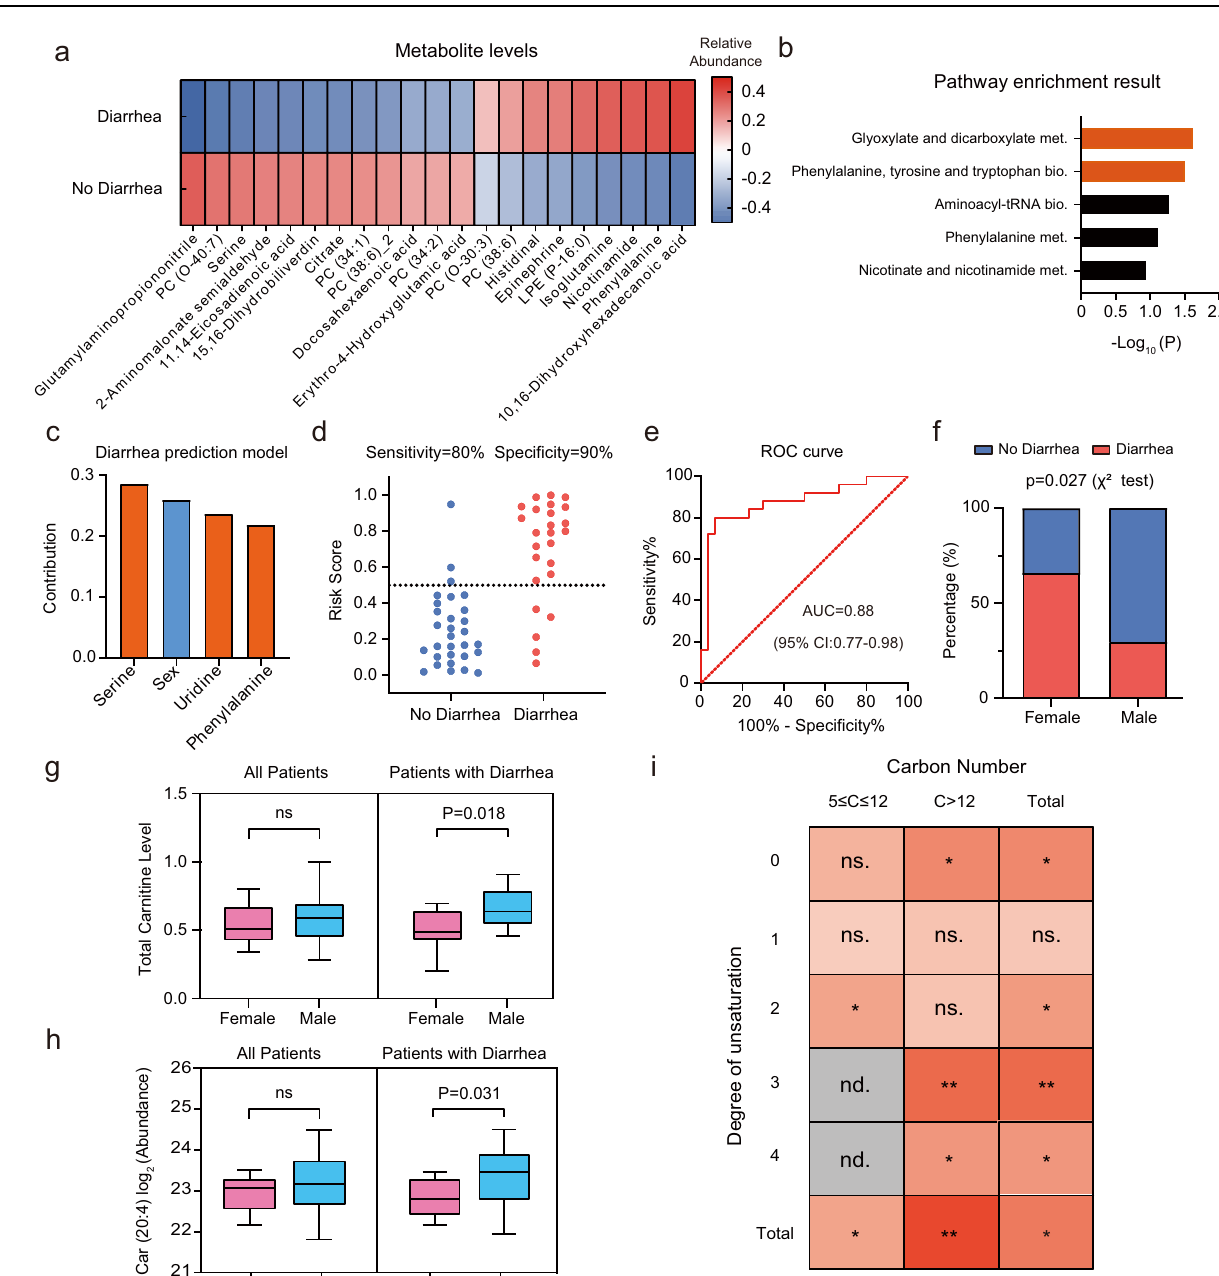
the logistic regression model. f Female patients had a signi fi cant higher chance of diarrhea than males ( P <0.05; χ 2 test). g , h Levels of total carnitines and Car (20:4) betweenfemalesandmalesinallpatients(Female: n =17;Male: n =38)andpatients with diarrhea (Female: n =12; Male: n =13). The centerline of boxes depicts the median values; the bottom and top box edges correspond to the fi rst and third quartiles, and whiskers indicated the minimum and maximum values. i Sex dis- parity of carnitine levels related to diarrhea induced by nCRT (nd., not detected; **, P <0.01; *, P <0.05; ns., not signi fi cant; Two-sided Wilcoxon